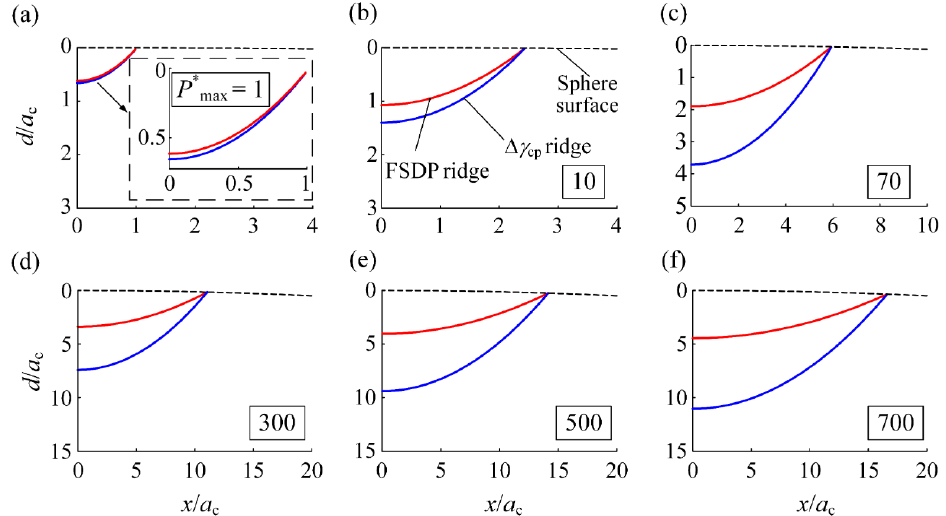
Figure 9. The ridge in the ∆ γ cp contour and the (upper) ridge in the FSDP contour for P * max = ( a ) 1, ( b ) 10, ( c ) 70, ( d ) 300, ( e ) 500 and ( f ) 700.